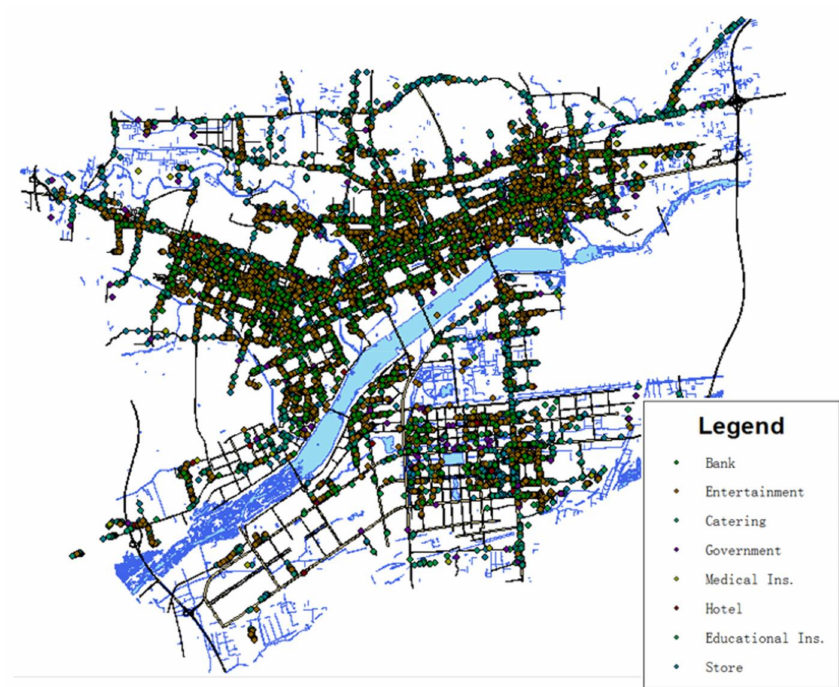
Figure 4. The data objects of